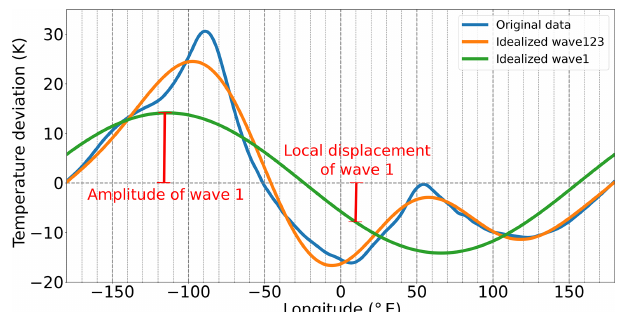
Figure 1. Illustration of the decomposition of the original time se- ries into wave number 1, 2 and 3 and of the concept of amplitude and local displacement which denotes the value at a specific longi-